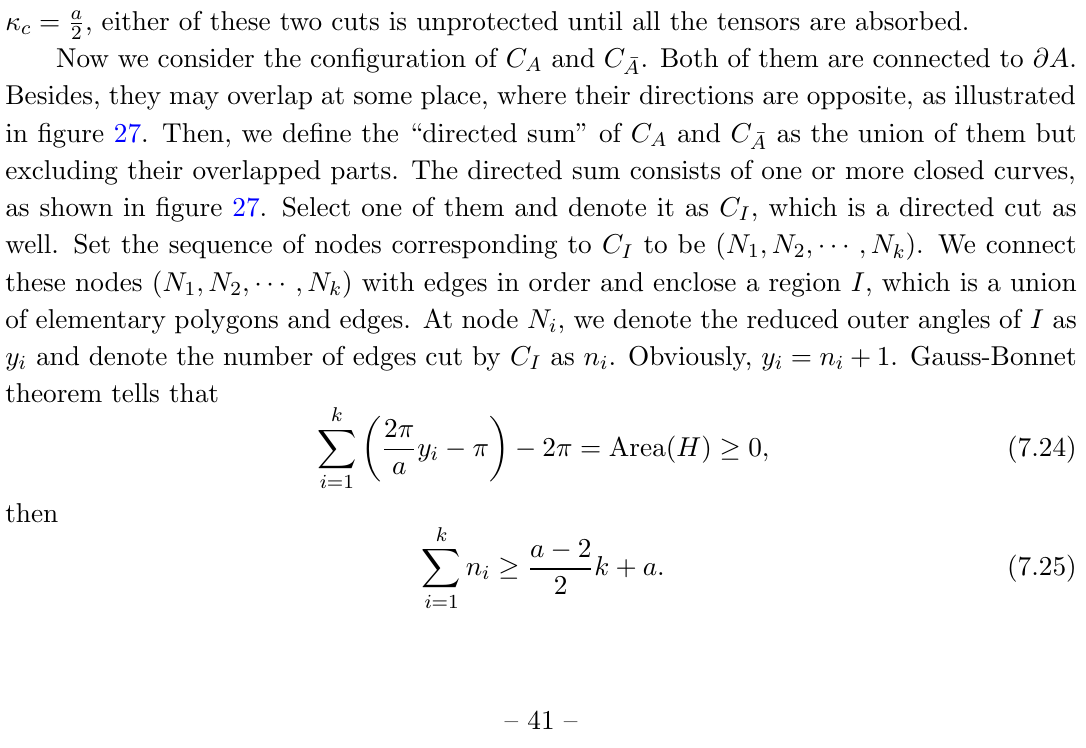
(yellow). The region I corresponding to C I is (cid:12)lled I